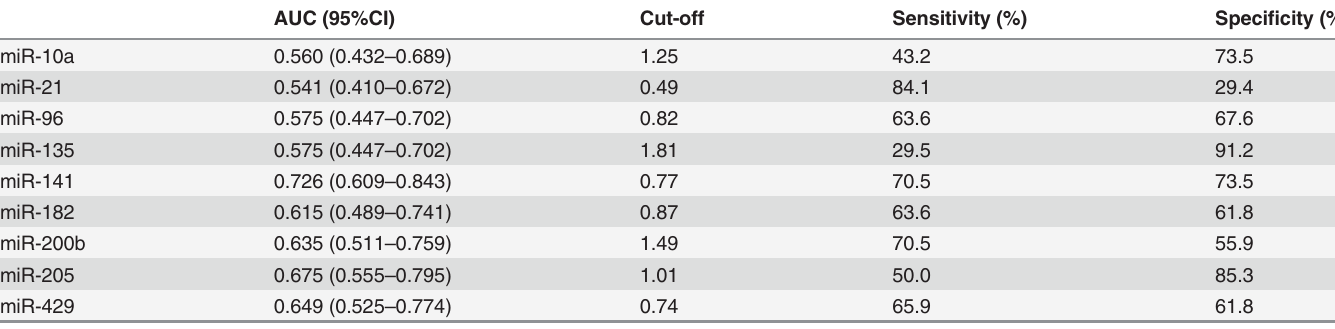
Table 2. Receiver operator characteristic analysis for serum